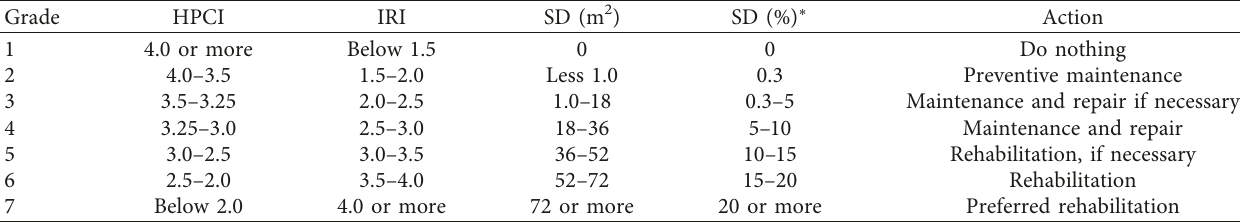
Table 3: Grade of pavement performance index of HPCI component for